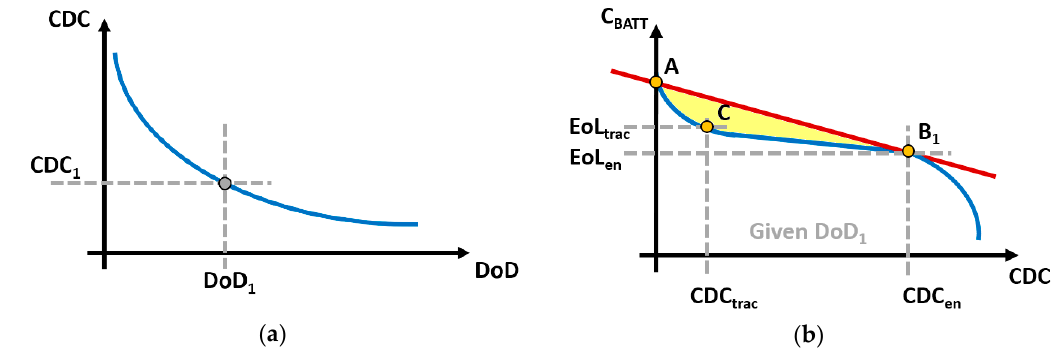
Figure 3. ( a ) Lithium batteries typical trend—maximum number of charging and discharging ( CDC ) vs. depth of discharge ( DoD ); ( b ) Linear approximation of lithium batteries typical trend—residual capacity vs. CDC .